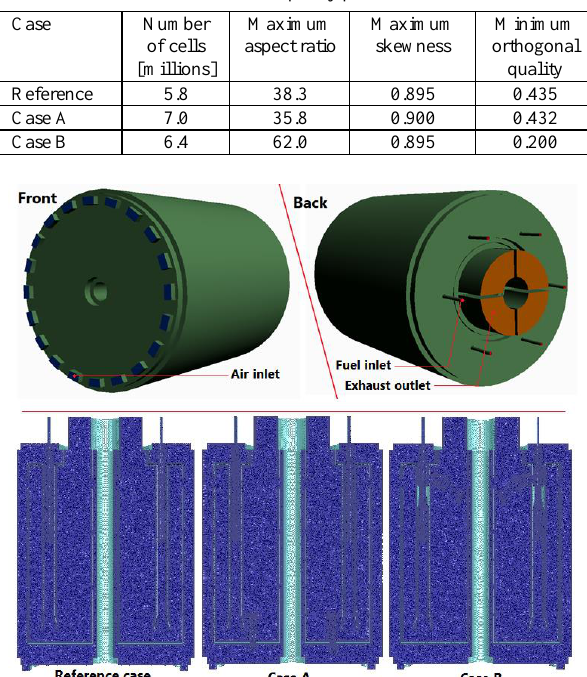
Table 2. Mesh quality parameters